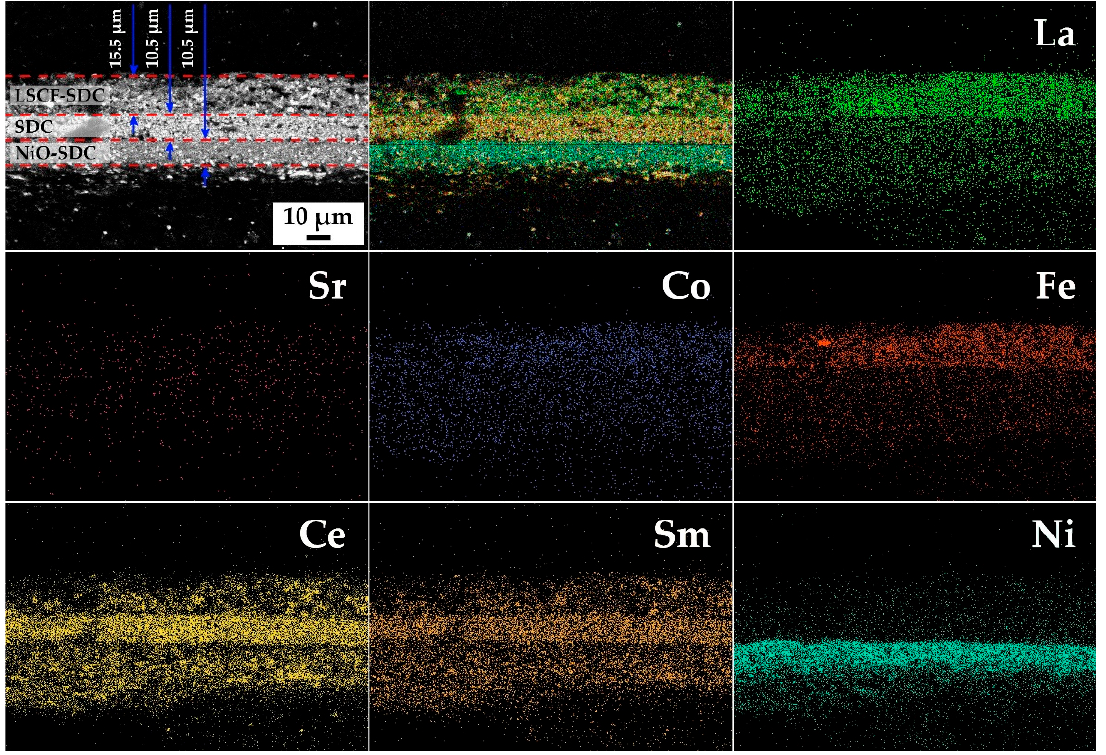
Figure 5. Microstructure of the cross-sectional area of the printed three-layer structure of the composition (NiO-SDC)/SDC/(LSCF-SDC), as well as chemical element distribution maps of its surface.